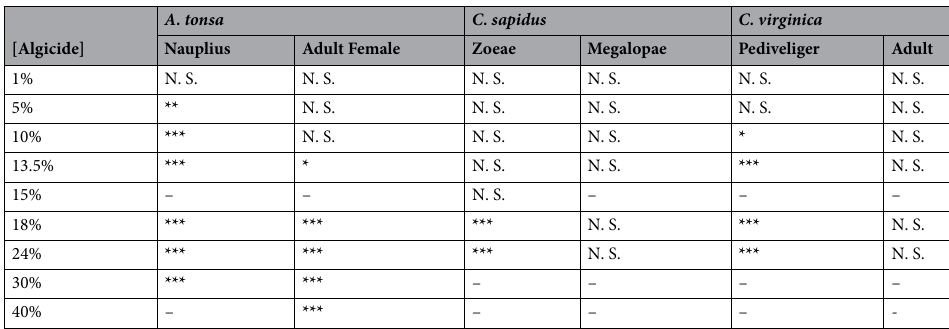
Table 2. P-values from Gehan-Breslow survival analysis ( p < 0.001 for all except C. sapidus megalopae and C. virginica adults, where p > 0.05) post-hoc analysis (Holm-Sidak). The left most column is concentration of algicide (% v/v). (– = Not tested; N. S. = Not significant, p > 0.05; * = p < 0.05; ** = p < 0.01, *** = p < 0.001).